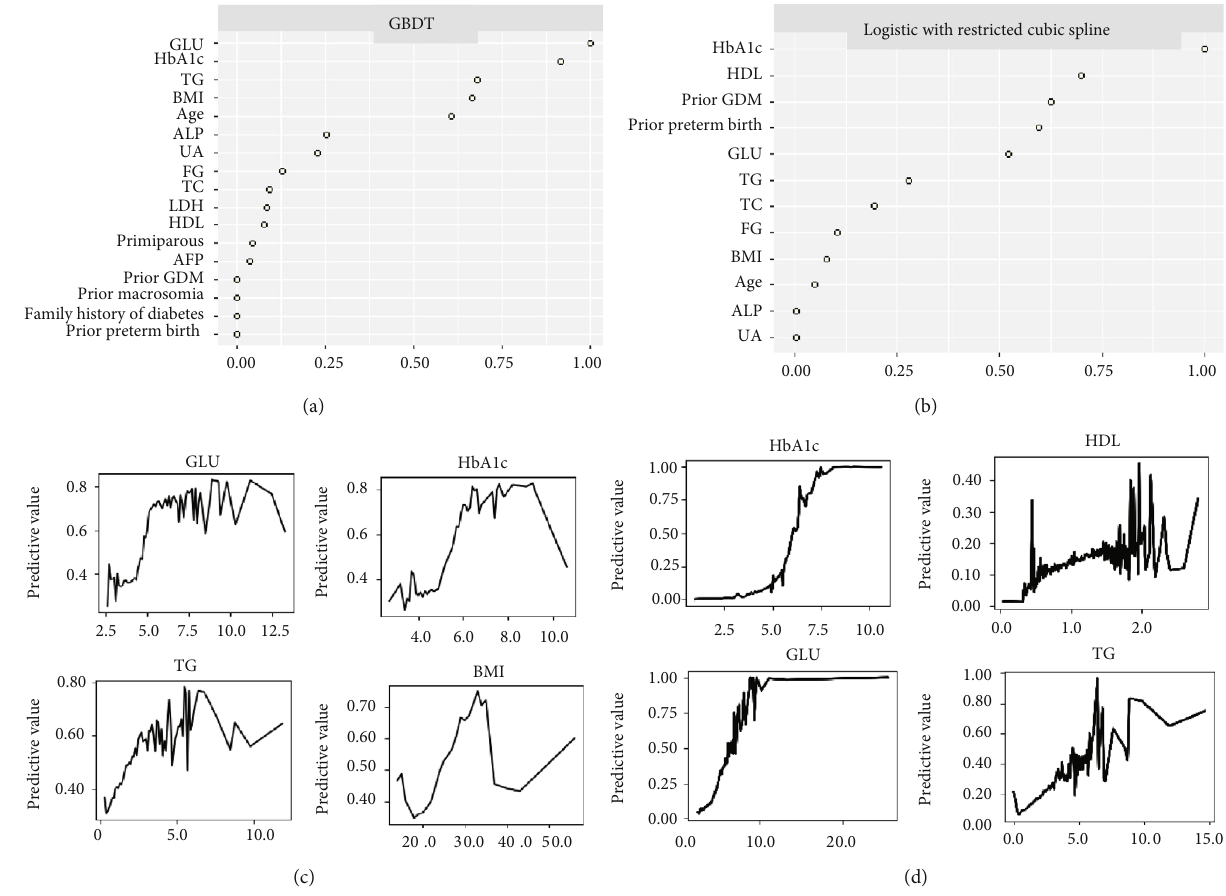
Figure 3: Contribution of the predictor variables in GBDT and the logistic regression model. (a) Importance of the predictor variables in the GBDT model in the validation cohort. (b) Importance of the predictor variables in the logistic model with restricted cubic spline in the validation cohort. (c) Partial plot of the e ff ects of fasting blood glucose (GLU, mmol/L), glycosylated hemoglobin (HbA1c, %), triglyceride (TG, mmol/L), and maternal BMI (kg/m 2 ) on the risk of GDM across di ff erent values in the GBDT model. (d) Partial plot of the e ff ect of glycosylated hemoglobin (HbA1c, %), high-density lipoprotein (HDL, mmol/L), fasting blood glucose (GLU, mmol/L), and triglyceride (TG, mmol/L) on the risk of GDM across di ff erent values in the logistic model with restricted cubic